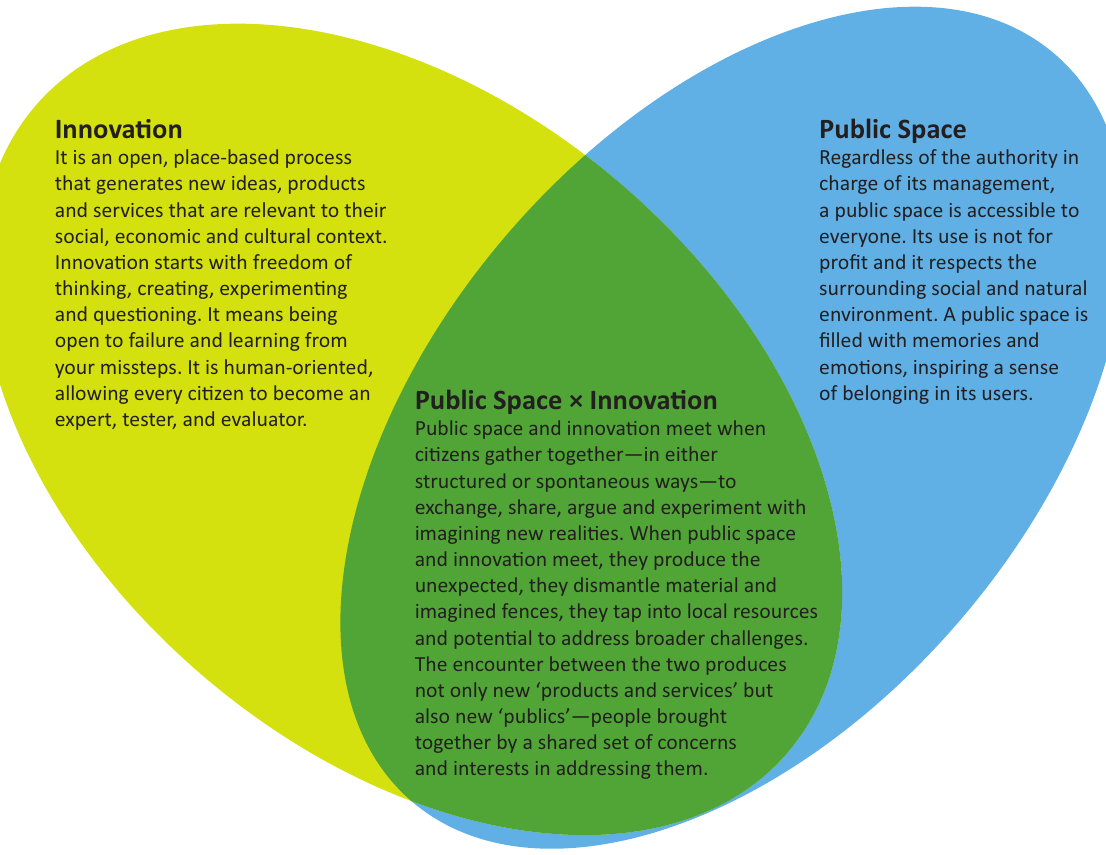
Figure 2. Framework for a PmLL at LMdV (2018). Source: Courtesy of